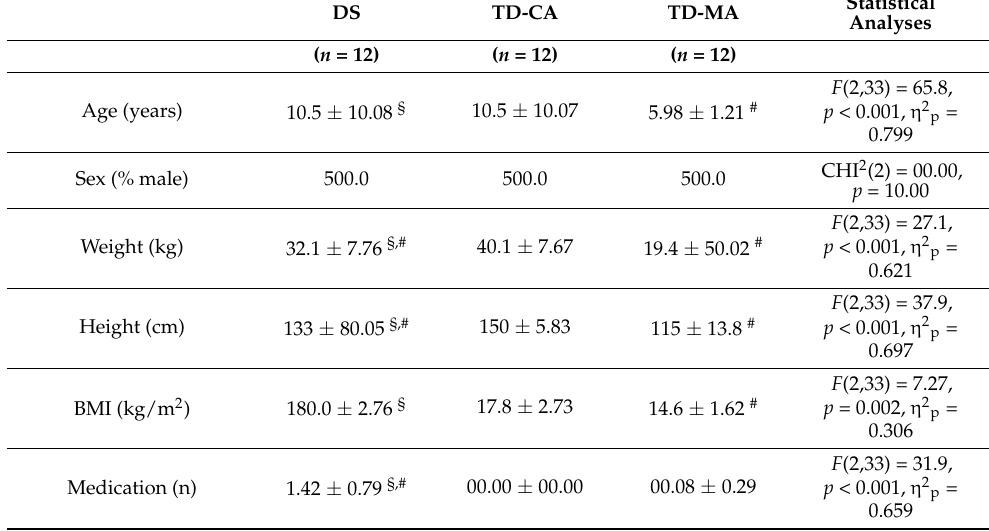
Table 1. Sampling characteristics of children with and without DS (adjusted chronological age (CA); adjusted mental age (MA)), including mean values (standard deviation) and receptive vocabulary scores of the Peabody Picture Vocabulary Test, 4th edition